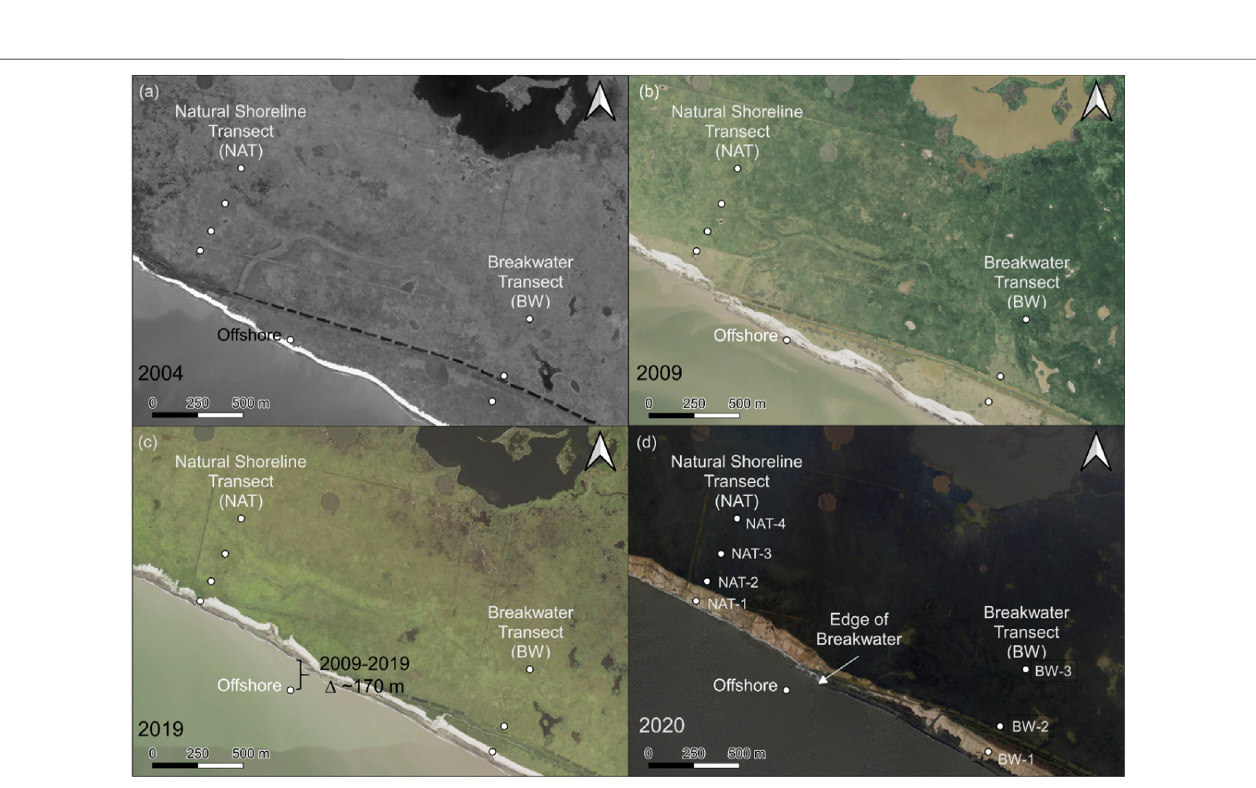
FIGURE2 | USDA NAIP imagery ofthestudy site in 2004 (A) , in 2009 (B) , in2019 showing ~170 m ofshorelineretreat (C) , and NOAA post-Delta aerial imagery in 2020 (D) showing the location of the two transects in relation to the breakwater structure.